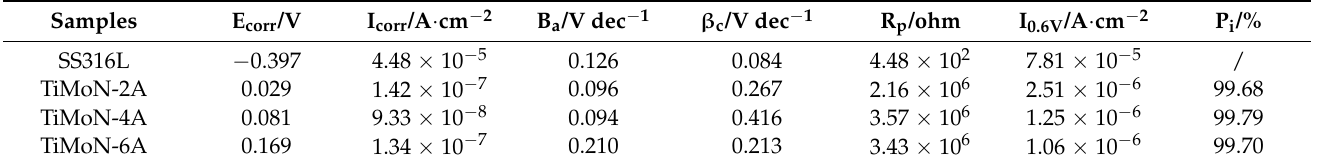
Table 5. Fitting consequences of potentiodynamic polarization of SS316L and TiMoN coatings. Samples